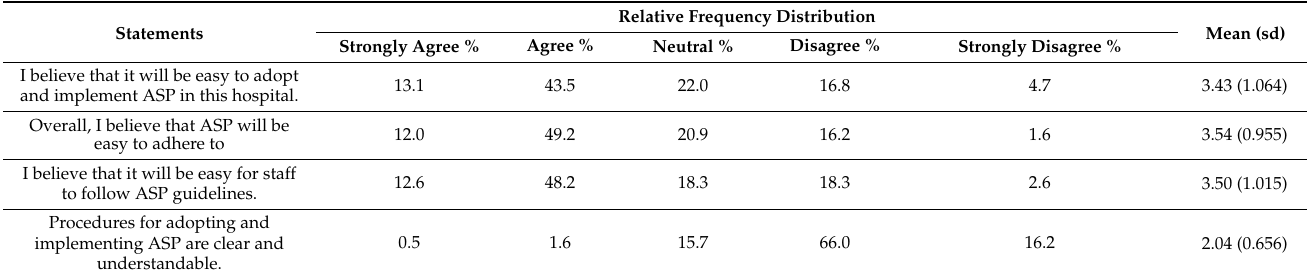
Table 4. The hospital participants’ perceived ease of use of ASPs.